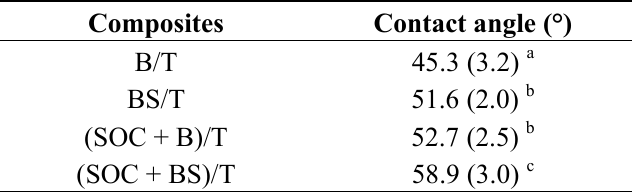
Table 1. The contact angles of the composites (mean ± sd).